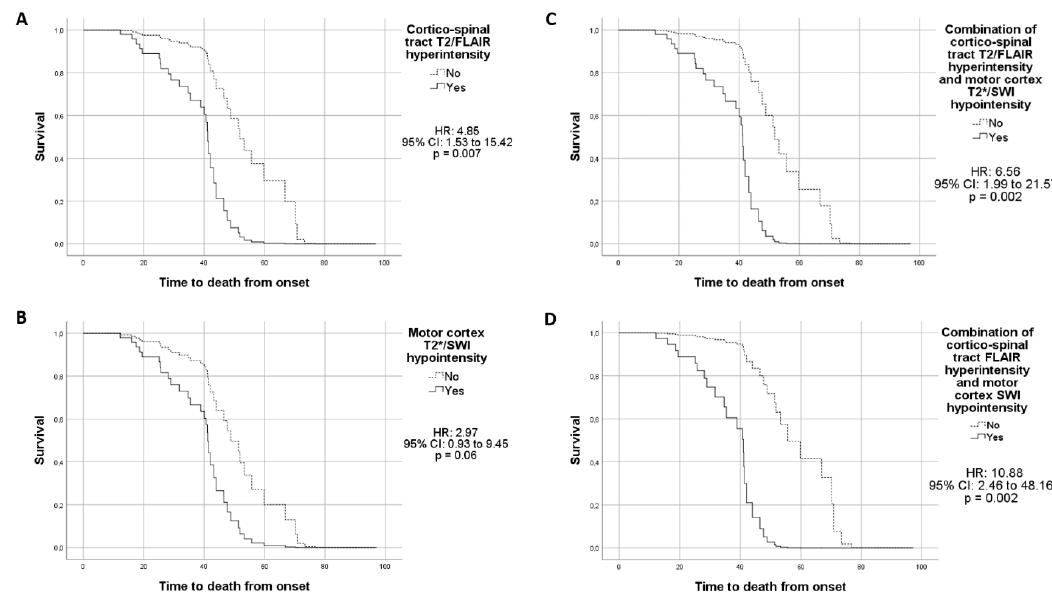
Figure 2. Results from the Cox proportional hazard models showing a shorter survival rate in ALS patients with CST T2/FLAIR hyperintensity ( A ), MC T2*/SWI hypointensity ( B ), combination of CST T2/FLAIR hyperintensity and MC T2*/SWI hypointensity ( C ), combination CST FLAIR hyperintensity and MC SWI hypointensity ( D